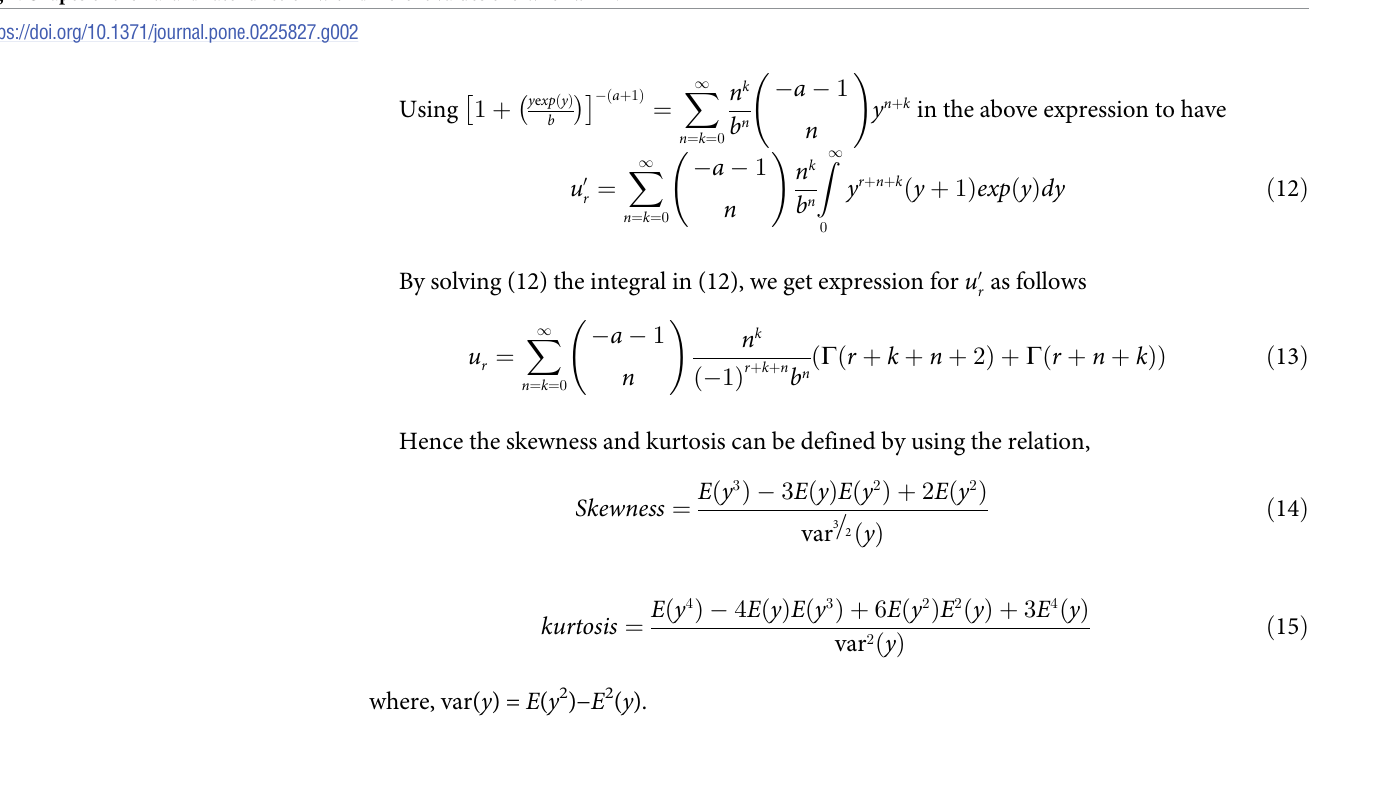
Fig 2. Shapes of the hazard rate function with different values of b when a =